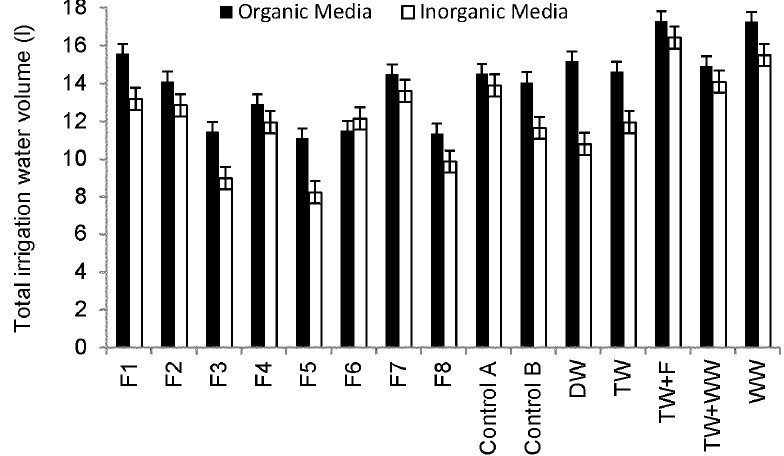
Figure 4. Overview of total irrigation water volumes for Sweet Pepper plants during the whole experiment period (11 October 2013 to 25 September 2014).